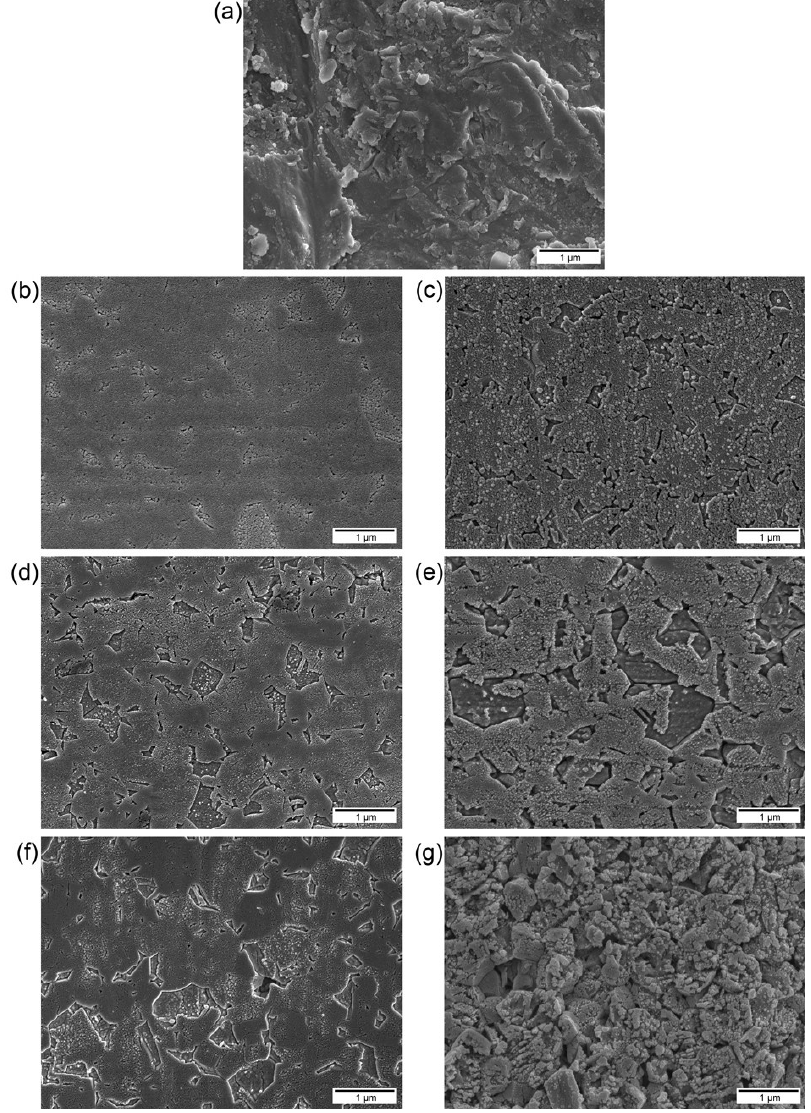
Figure 1. Scanning electron microscopy (SEM) surface images of the zirconia ceramic specimens after different surface treatments (20,000× magnification, bar = 1